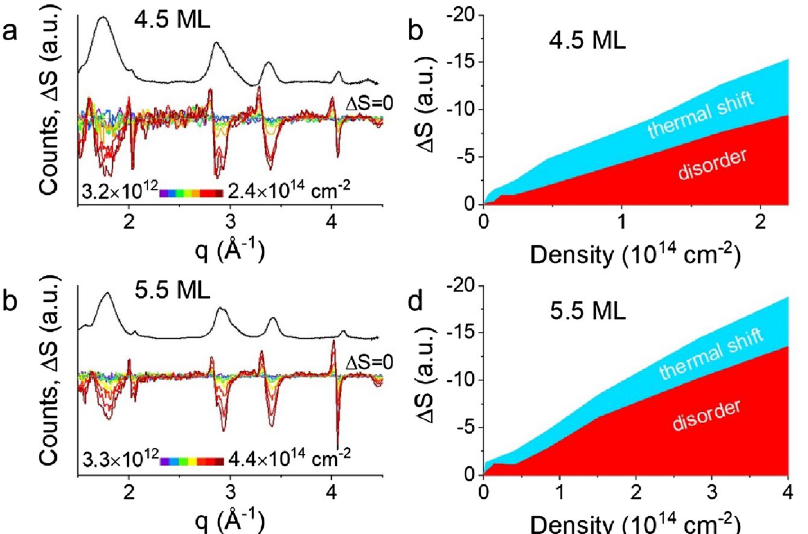
Figure 7. ( a , b ) Static X-ray diffraction pattern (black line) and transient X-ray diffraction patterns (ΔS) as a function of power at 40 ps pump-probe delay using 3.1 eV pump photon energy. Data are shown for ( a ) 7.4 nm × 23 nm 4.5 ML and ( b ) 7.6 nm × 41 nm 5.5 ML CdSe CQW samples. ( c , d ) Quantification of the magnitude of ΔS signal as a function of excitation density for the same samples. Total ΔS signal is disambiguated into signal arising from thermal disordering and shift of the diffraction